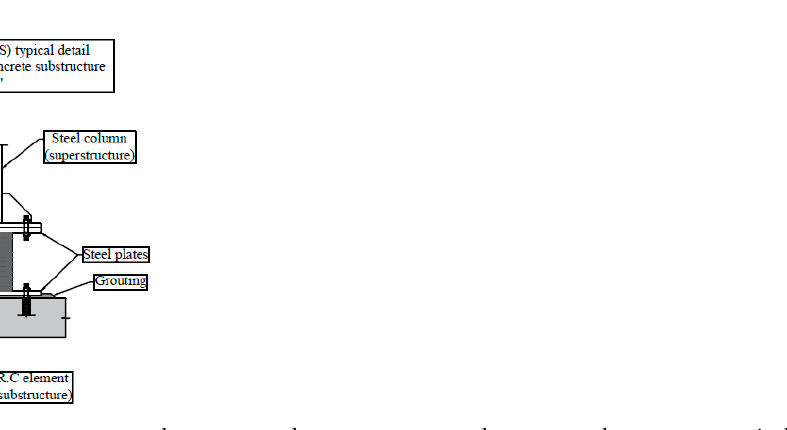
Figure 9. Base isolator system attachment to steel superstructure and concrete substructure—typical detail (after [20,32,33]).